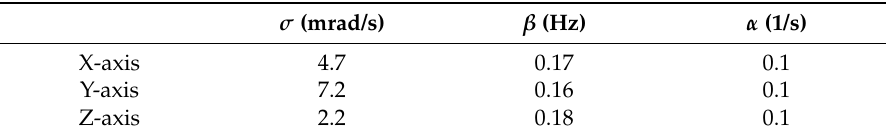
Table 2. Model parameters of ship angular velocity.